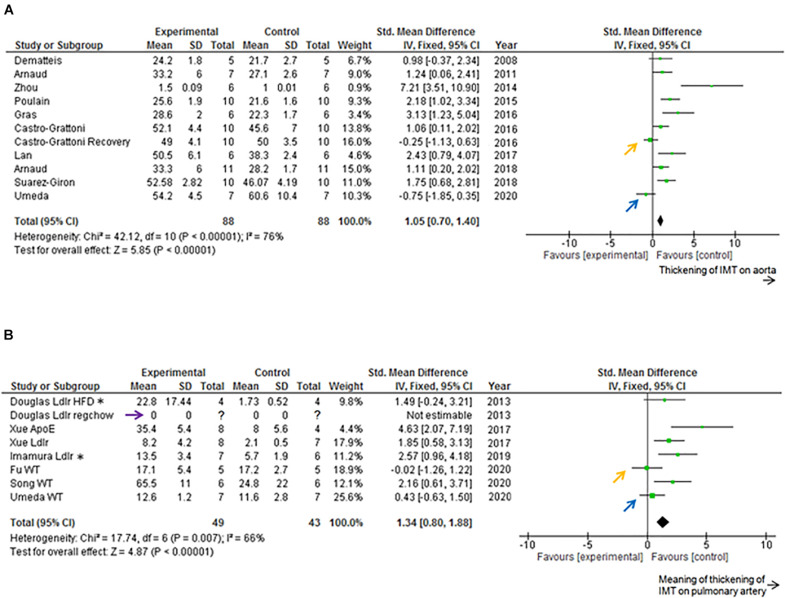
Forest plot. (A) Effect of intermittent hypoxia (IH) on intima-media thickness (IMT) of descending aorta. IH significantly increased aortic IMT (P < 0.01). Castro-Grattoni et al. (2016) examined both the effects of IH and those after 6 weeks of normoxic recovery (orange arrow). Current data are those after 5 weeks of normoxic recovery (blue arrow). Only 4–5 per condition were used by Dematteis et al. (2008) and Gras et al. (2016) used 5–6 mice per condition, and Arnaud et al. (2018) employed 9–13 mice per condition. All the experiments were performed on wild-type mice. (B) Effect of IH on IMT of pulmonary artery (PA). IH significantly increased IMT-associated parameters of PA (P < 0.01). Douglas et al. (2013) used both regular chow and high fat diet, and reported that regular chow did not cause atherosclerotic lesions of PA (purple arrow). Xue et al. (2017) and Imamura et al. (2019) used high fat diets. Douglas et al. (2013); Xue et al. (2017), and Imamura et al. (2019) used transgenic mice. Fu et al. (2020) reported that IH did not increase IMT of PA (orange arrow). Current data after normoxic recovery phase (blue arrow). ApoE, ApoE knockout mice; CI, confidence interval; HFD, high fat diet; IV, inverse variance-weighted method; Ldlr, Ldlr knockout mice; regchow, regular chow; SD, standard deviation; WT, wild-type mice. *Data of 8 week, 10 h/d exposure to Ldlr knockout mice.